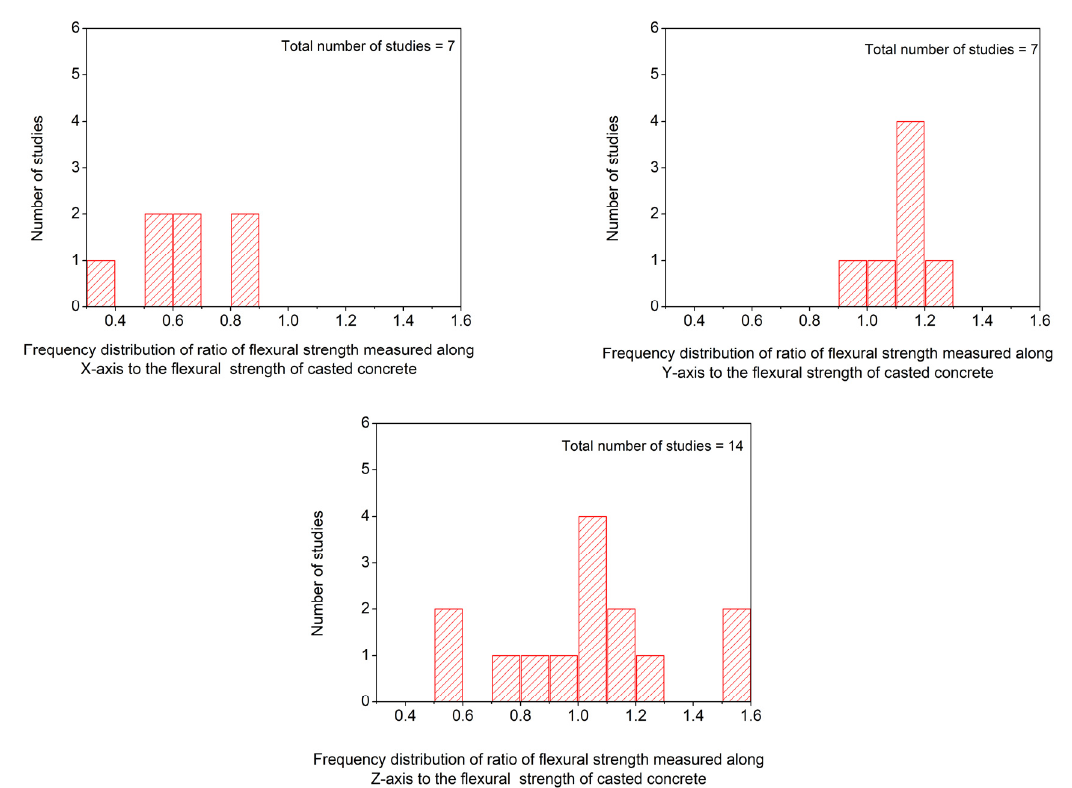
Figure 10. Anisotropy in flexural strength of 3D-printed concrete at different printing directions [1,61,125,127,135,142,151,165,175,178–180,183,184,187].